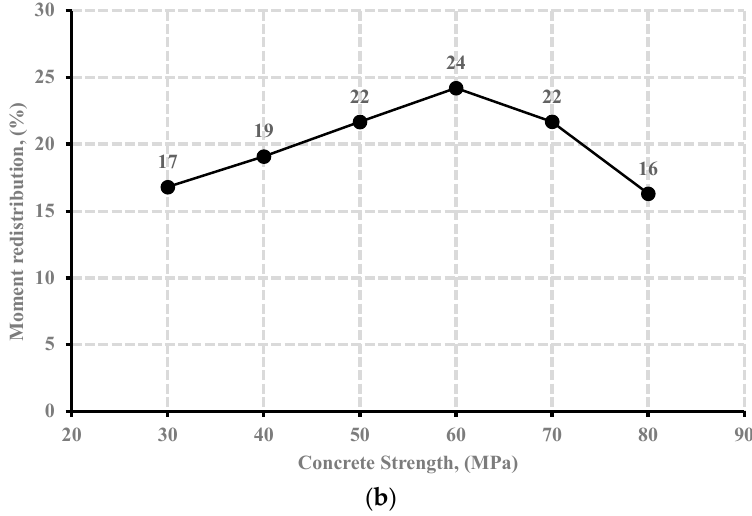
Figure 9. ( a ) Load ‐ deflection curve with varied concrete strength and ( b ) Moment redistribution under variable concrete strength.